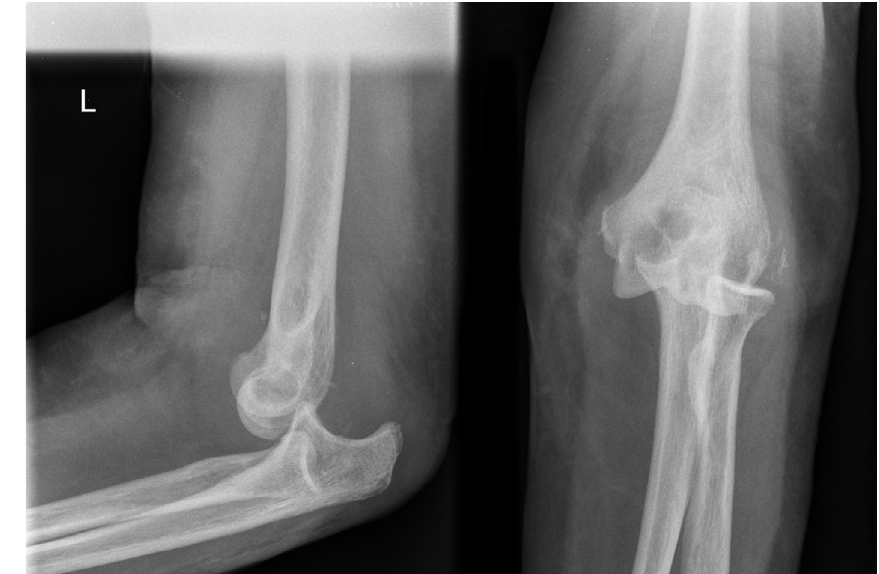
Figure 6. Elbow AP and lateral radiographs demonstrating failure of first